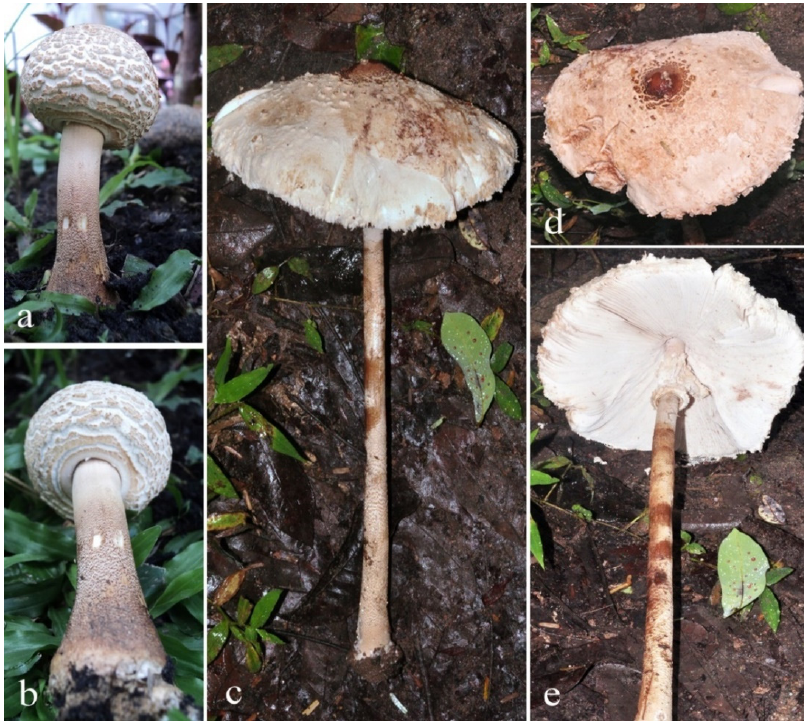
Diversity 2021 , 13 , 666 Figure 15. Fresh basidiomata of Macrolepiota detersa in situ. ( a , b ) MFLU 12-1784. ( c – e ) MFLU 12-1772.